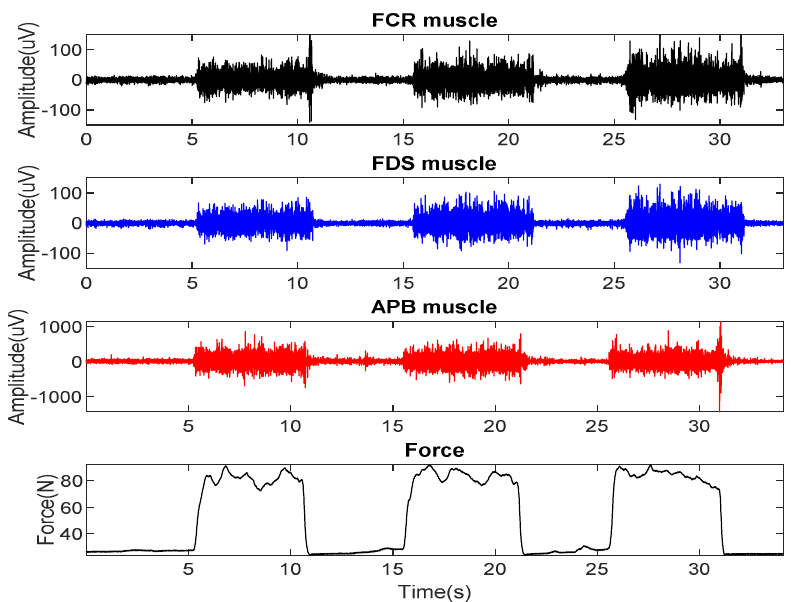
Fig. 6. A plot of the EMG for the fine pinch with 70% MVC for participant 3 (female participant). The top 3 figures represent the 3 trials of EMG from the FCR, FDS and APB, respectively. The bottom figure is the force signal measured in Newton with hand dynamometer